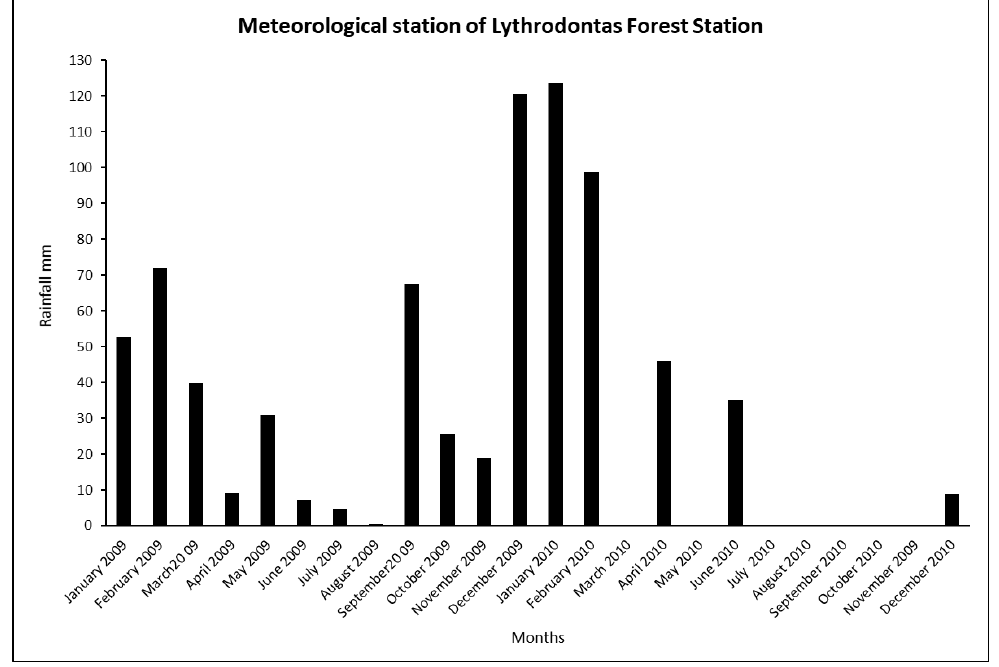
Figure 1. Monthly rainfall data from January 2009 to December 2010 obtained from the meteorological station of the Lythrodontas Forest Station.